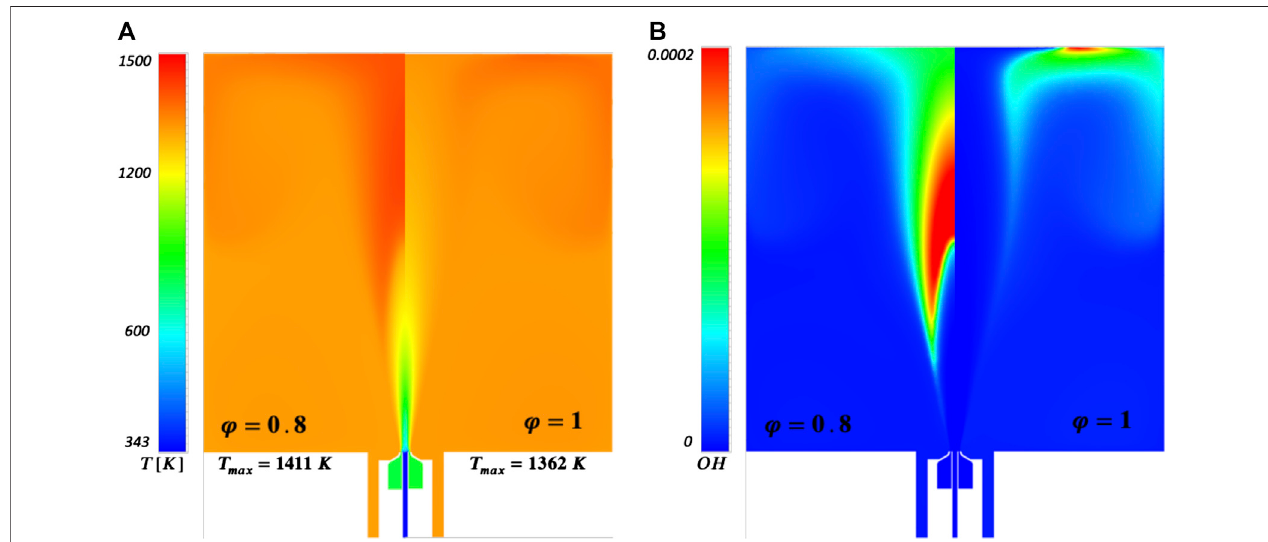
FIGURE 5 | Temperature and OH comparison for different equivalence ratio values at 30% H 2 (cases 1 and 4).